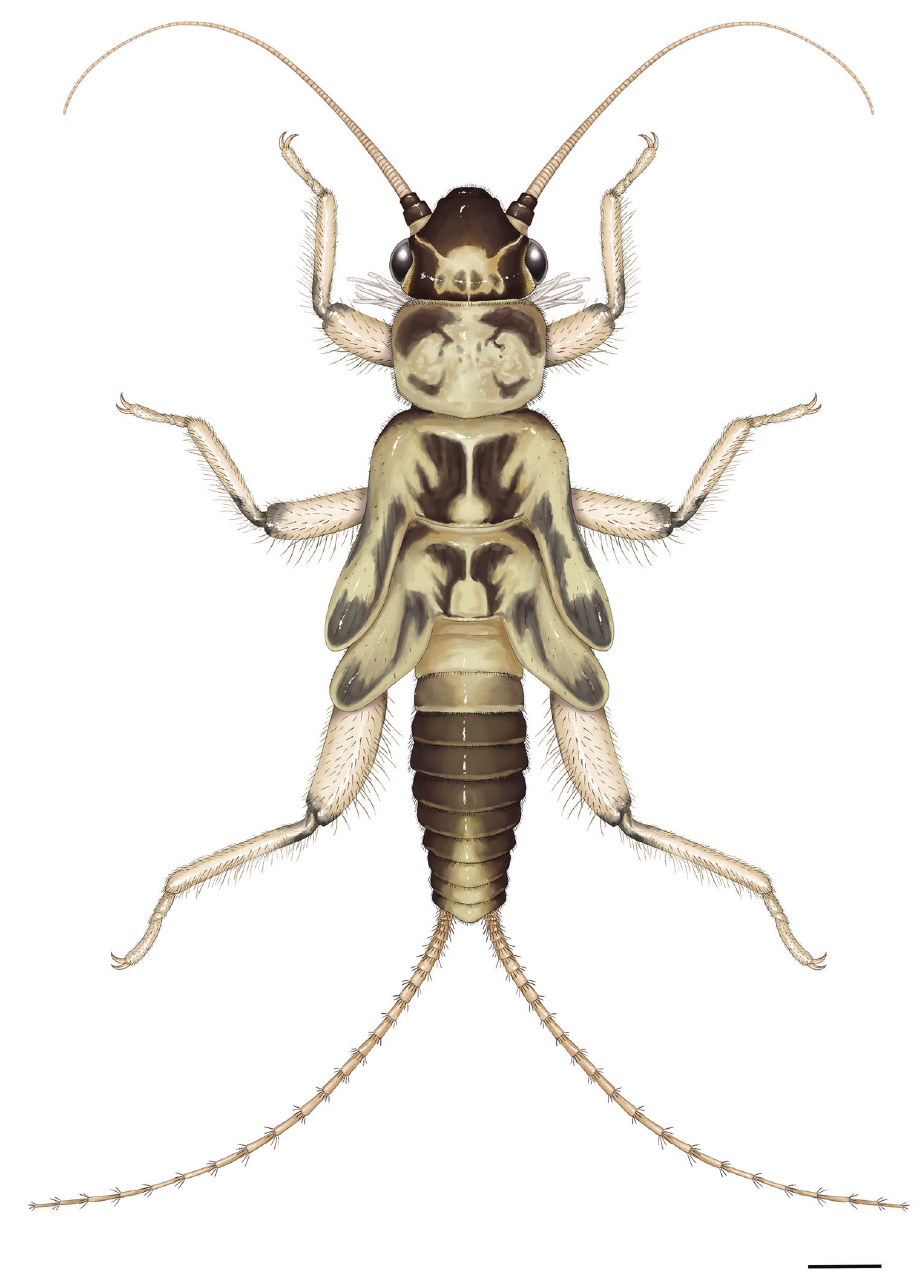
Figure 22. Amphinemura dingoidea sp. n., habitus of matured male paratype larva. Scale bar: 0.5